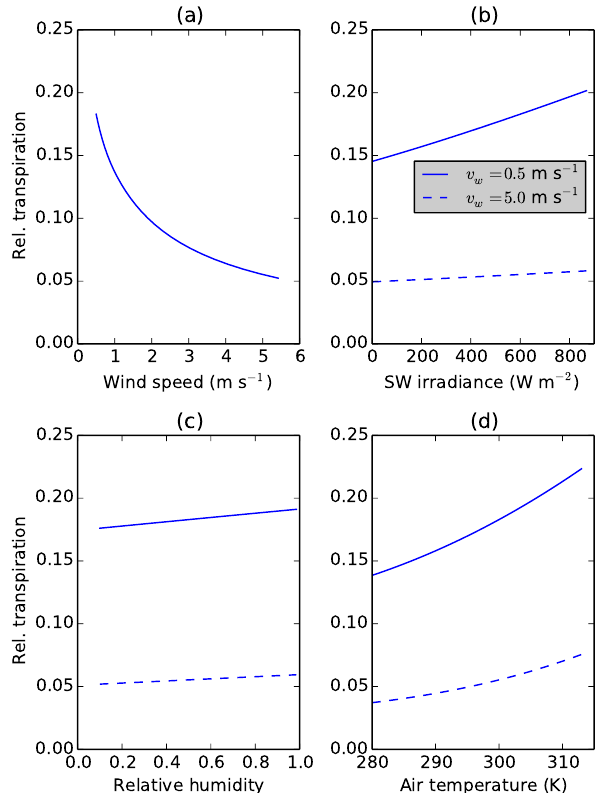
Figure 4. Simulated relative transpiration (latent heat flux at low stomatal conductance (0.001ms − 1 ) divided by that at infinite stom- atal conductance as functions of (a) wind speed, (b) shortwave irra- diance, (c) relative humidity and (d) air temperature. (b) – (c) display two curves, one for low wind speed ( v w = 0 . 5ms − 1 , solid line) and one for high wind speed ( v w = 5 . 0ms − 1 , dashed line). Stan- dard simulation conditions: 5cm wide leaf, 600Wm − 2 shortwave irradiance, 300K air temperature and 50% relative